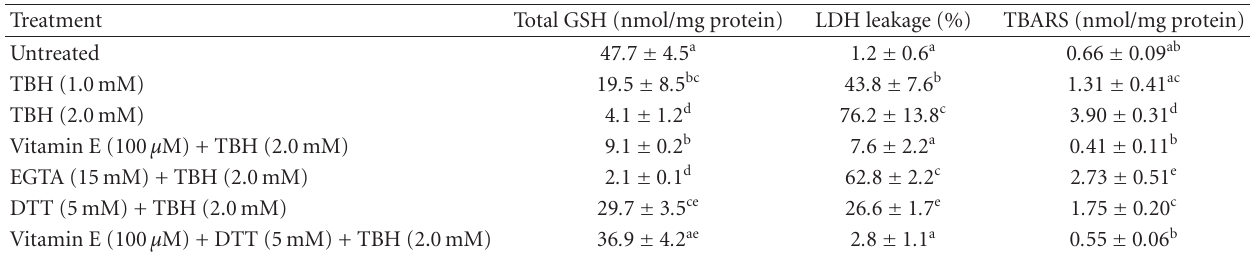
Table 1: E ff ect of vitamin E and DTT on total GSH content, LDH leakage, and TBARS production in rat hepatocytes with TBH treatment.